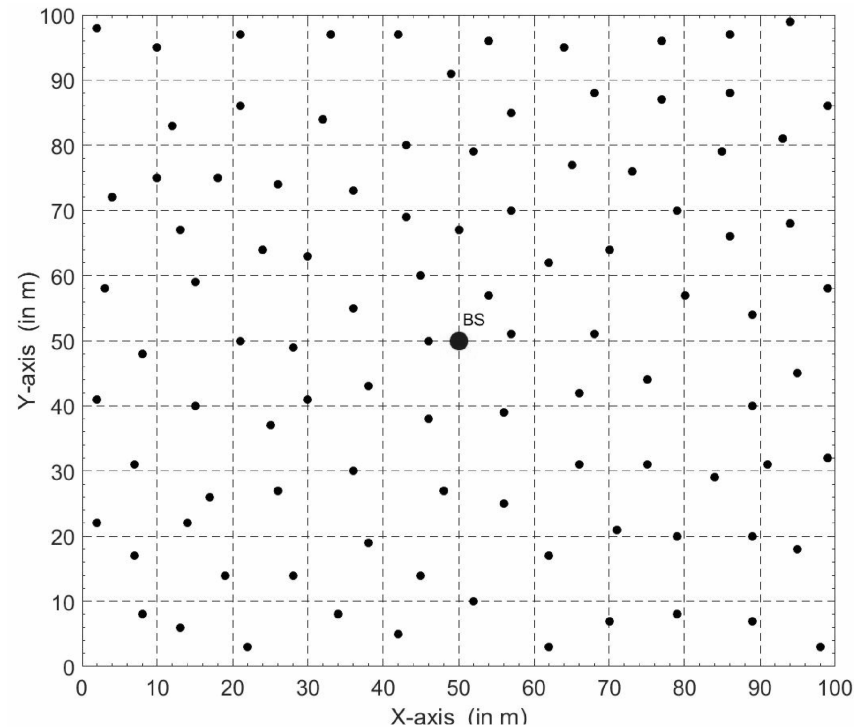
Figure 2. One-hundred sensor nodes’ random distribution in the deployment scenario of a 100 m × 100 m square region, and the coordinate (50, 50) of the